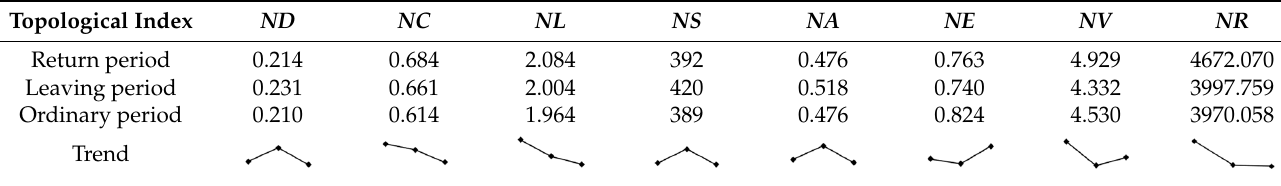
Table 3. Network structure resilience.